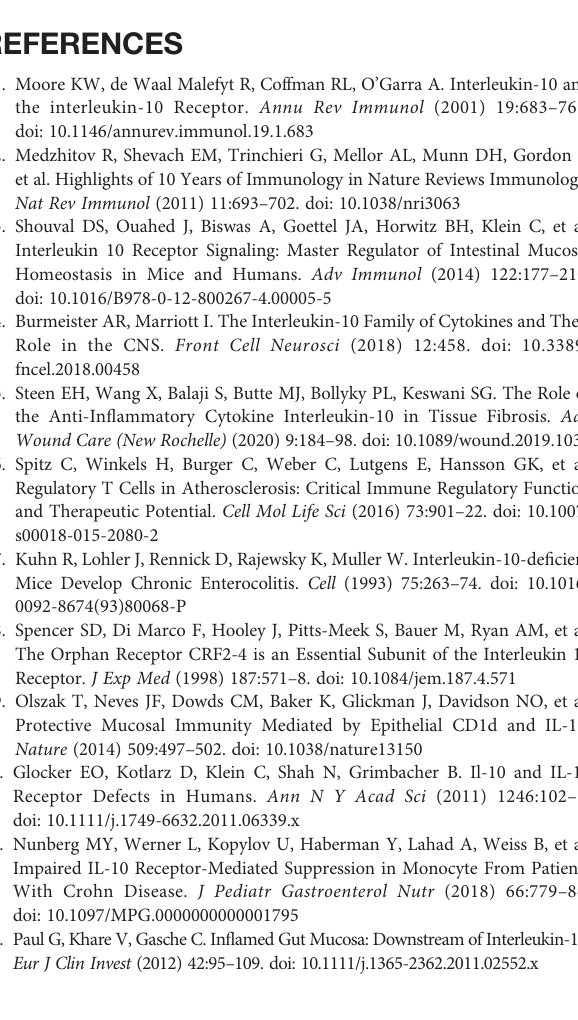
Supplementary Table 1 | Geneontology enrichment of the TNF-induced sample.